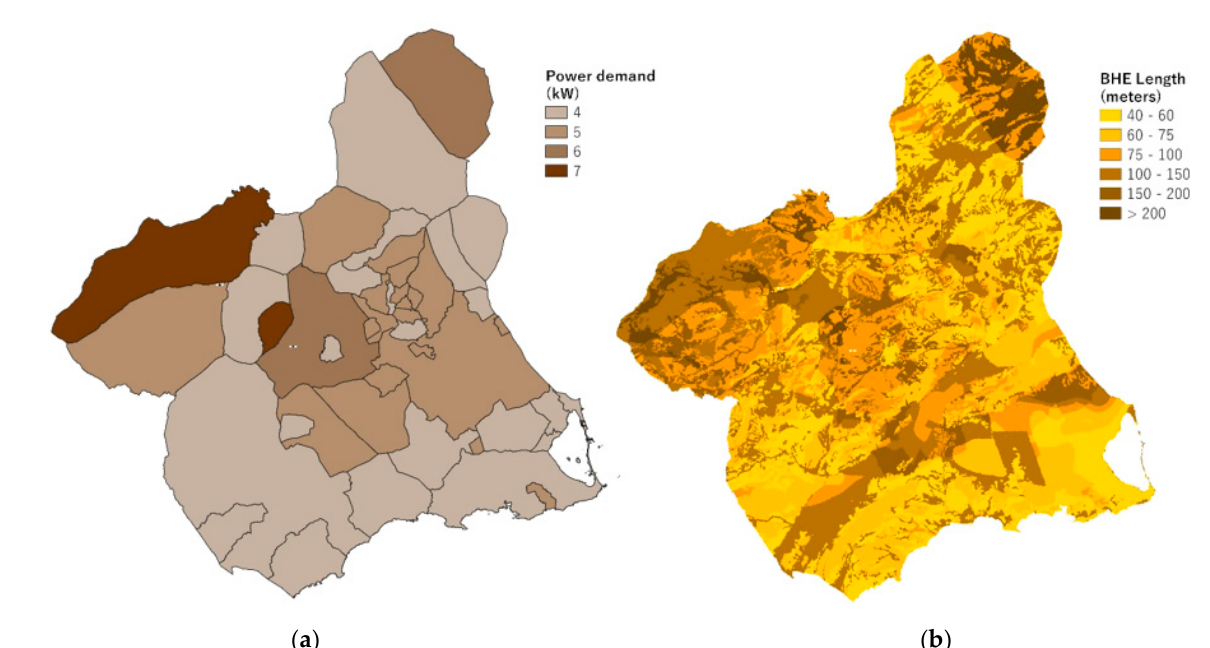
Figure 9. Power demanded to supply heating and cooling need by municipality ( a ) and BHE length required to supply these needs ( b ).